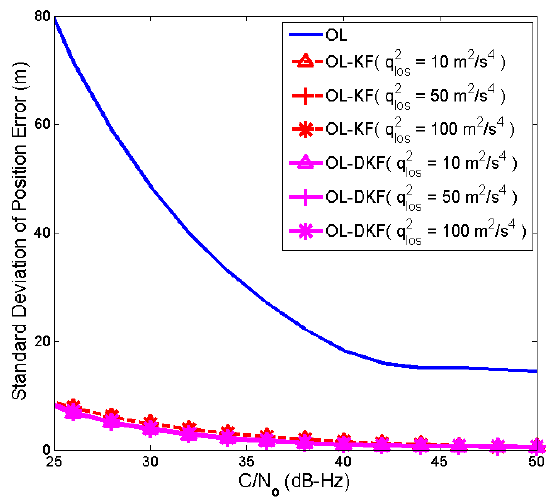
Figure 11. Standard deviation of the position error (10 sats).